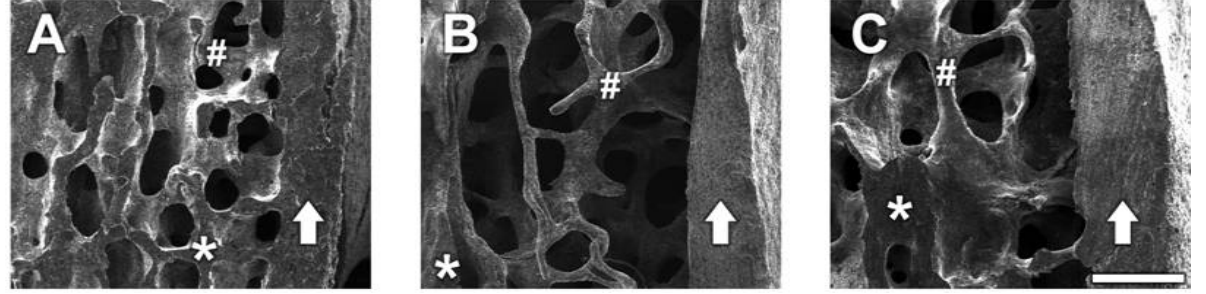
Figure 6. ( A ) Electron microscopic images of lumbar vertebrae in sham group, ( B )